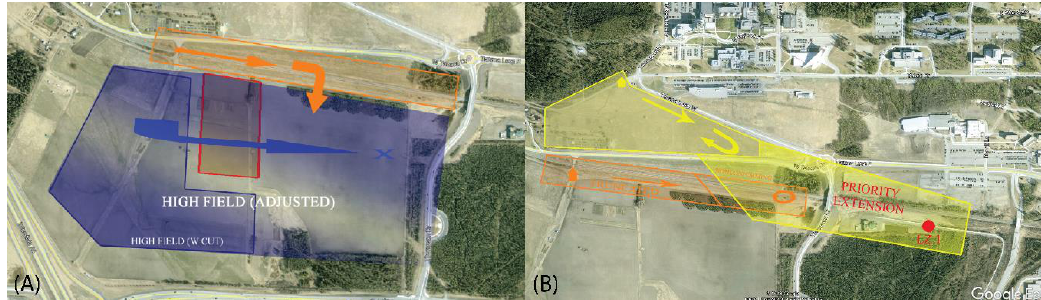
Figure 16. ( A ) Airspace for the statically controlled airspace allocation scenario and ( B ) airspace for the dynamically controlled airspace allocation scenario.